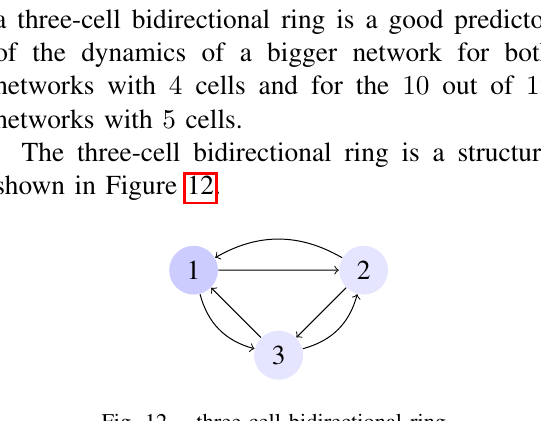
Fig. 12. three-cell bidirectional ring